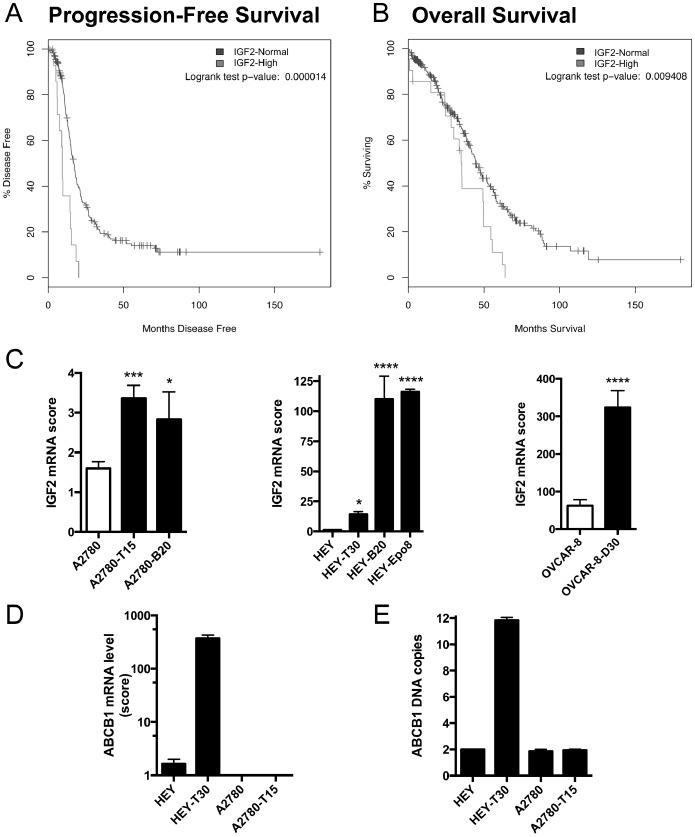
High IGF2 expression is associated with early recurrence, poor survival, and drug resistance.IGF2 expression and ovarian cancer survival. Using the cBioPortal for Cancer Genomics to analyze the data from the Cancer Genome Atlas study of ovarian serous cystadenocarcinoma, we compared the progression-free survival and overall survival in patients with high tumor levels of IGF2 mRNA (greater than 1.6 standard deviations above the mean; gray line) and those with normal tumor levels of IGF2 mRNA (all other patients; black line). Patients with high IGF2 mRNA levels had significantly shortened progression-free survival (A) and overall survival (B). (C) IGF2 expression in sensitive and resistant cell lines. By RT-qPCR, we measured the IGF2 mRNA level in six drug resistant ovarian carcinoma cell lines and their three cell lines of origin. All drug resistant cell lines have significantly higher IGF2 mRNA expression compared to their sensitive cell line of origin. Bars show the mean±SEM of IGF2 mRNA expression score for at least two independent experiments for each cell line, each done in triplicate, and the symbol above the bar indicates the statistical significance comparing that resistant cell line with its parental counterpart; *p<0.05, ***p<0.001, ****p<0.0001 by One-way ANOVA with Bonferroni posttest. (D) ABCB1 expression. ABCB1 mRNA expression levels were measured by RT-qPCR in HEY, HEY-T30, A2780 and A2780-T15. HEY-T30 has higher ABCB1 mRNA expression compared to the other cell lines. Bars show the mean±SEM of ABCB1 mRNA expression score for at least four independent experiments for each cell line, each done in triplicate, (E) ABCB1 DNA copy number. By qPCR performed on genomic DNA, HEY-T30 has a six-fold increase in ABCB1 DNA copy number indicating gene amplification. Bars show the mean±SEM of two independent experiments, each done in triplicate.